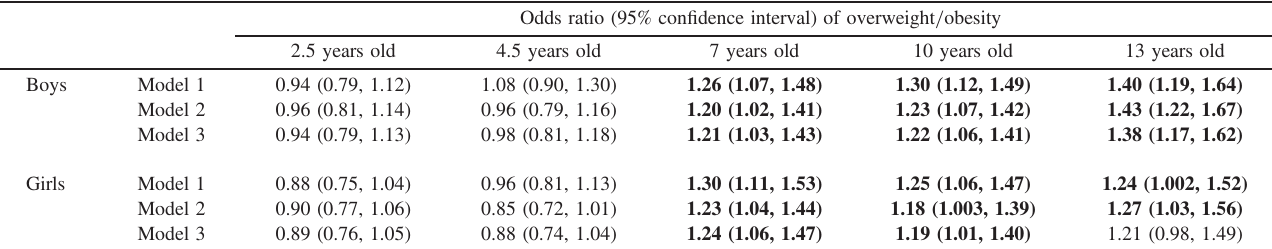
Table 4. Multivariable adjusted odds ratios of overweight / obesity for skipping breakfast at 2.5 years old